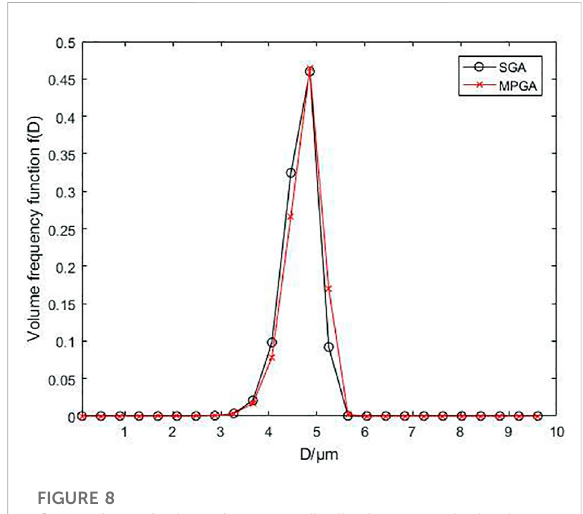
FIGURE 8 Comparisonofvolumefrequencydistribution mapsobtained from inversion with SGA and